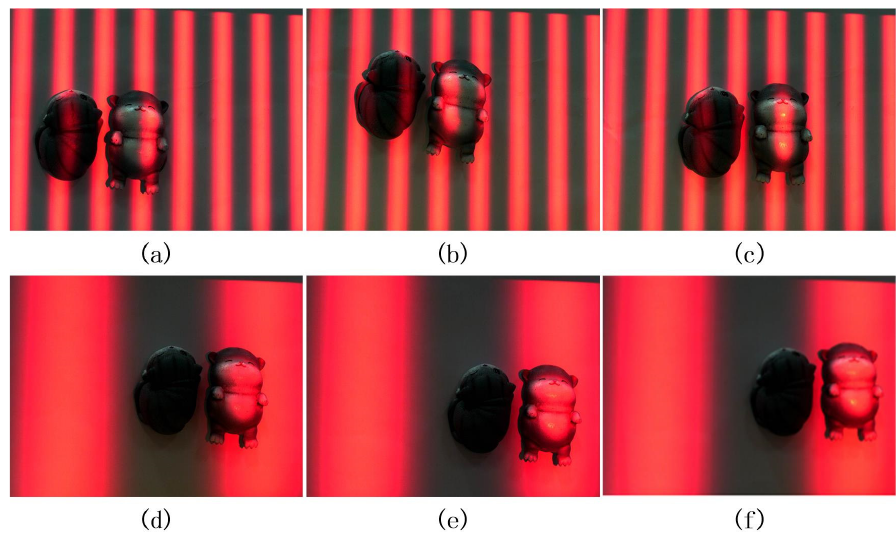
Figure 2. The captured object images of different frequencies. ( a – c ) The object image of high frequency; ( d – f ) the object image of low frequency.